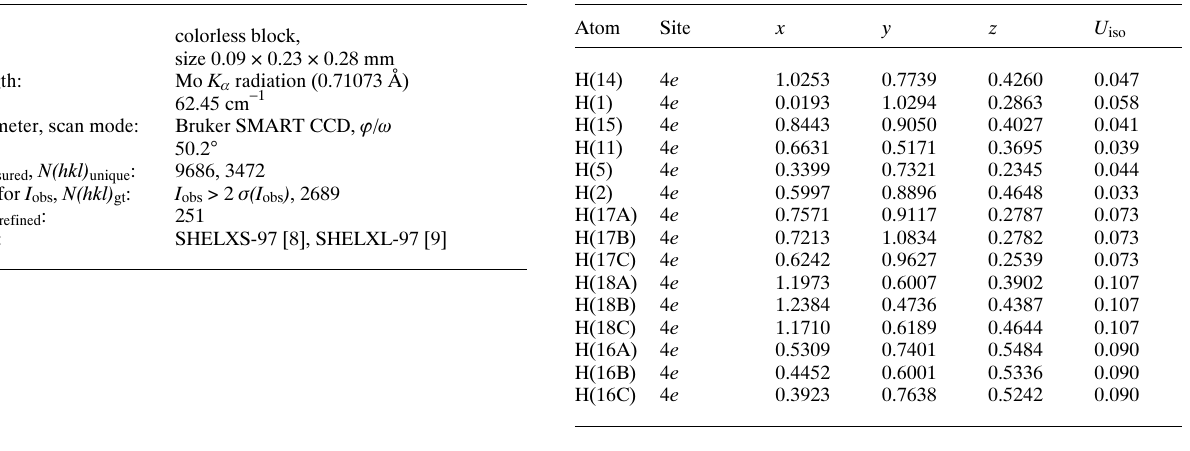
Table 2. Atomic coordinates and displacement parameters (in Å 2 ) . Table 1. Datacollection and